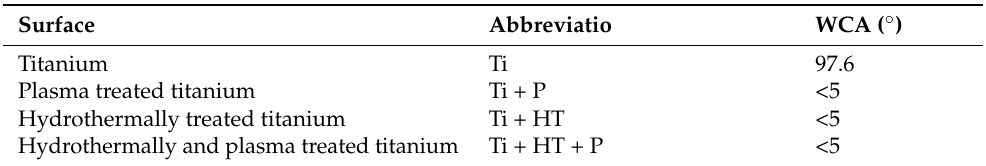
Table 1. Surfaces prepared by different treatment methods, abbreviations of the samples with corresponding data on WCA.